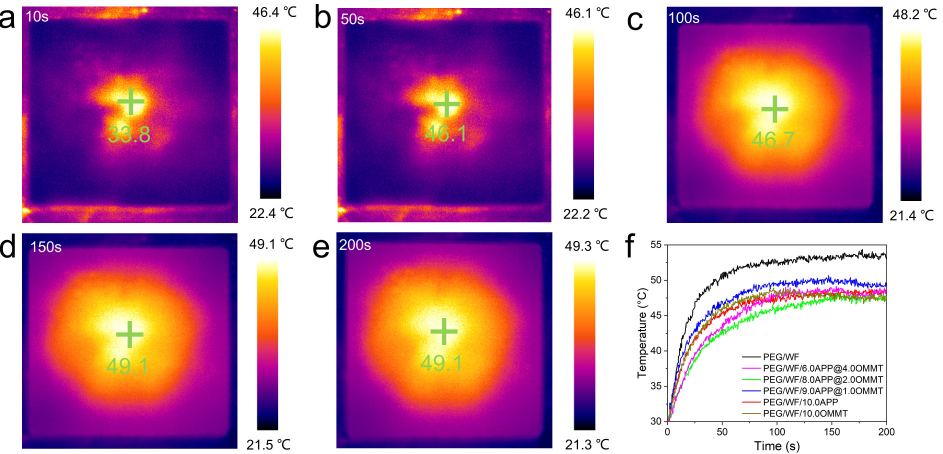
Figure 8. Representative thermal images of photothermal performance ( a – e ) and temperature-time curves of samples ( f ).